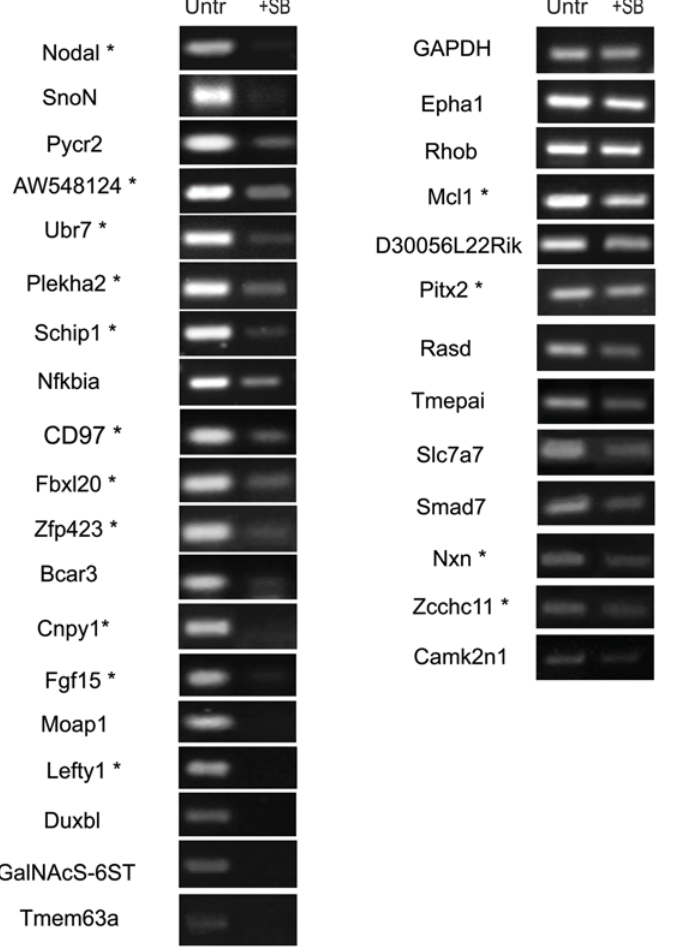
Figure 5. The identified direct target genes are expressed in the mouse embryo under Nodal/Smad2 signalling activation. RT-PCR on identified direct target genes from E5 embryos cultured with inhibitor (SB) or without (Untr) for 18 hours. All the tested genes are expressed in uninhibited embryos (Untr). Like Nodal (positive control) the majority of identified target genes are downregulated under SB treatment. No effect on GAPDH (negative control) expression shows that SB does not generally inhibit gene transcription in cultured embryos. Genes marked with (*) contain predicted Foxh1 binding elements (ASE).